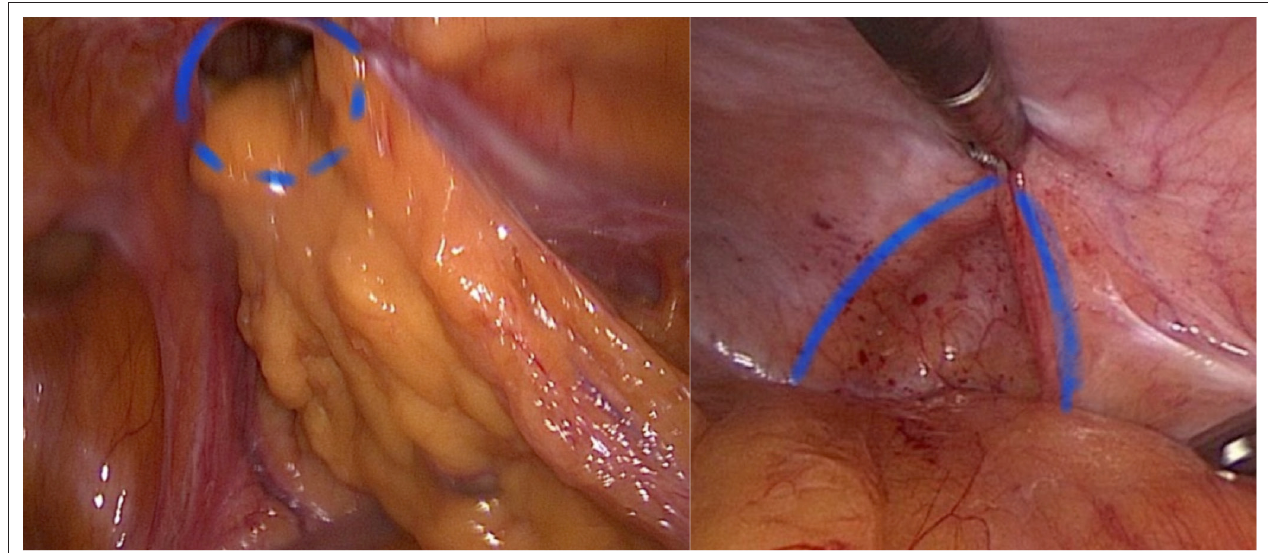
FIgure 2 | Fascial edges are marked with blue lines. The left part of the image depicts herniated parts of the